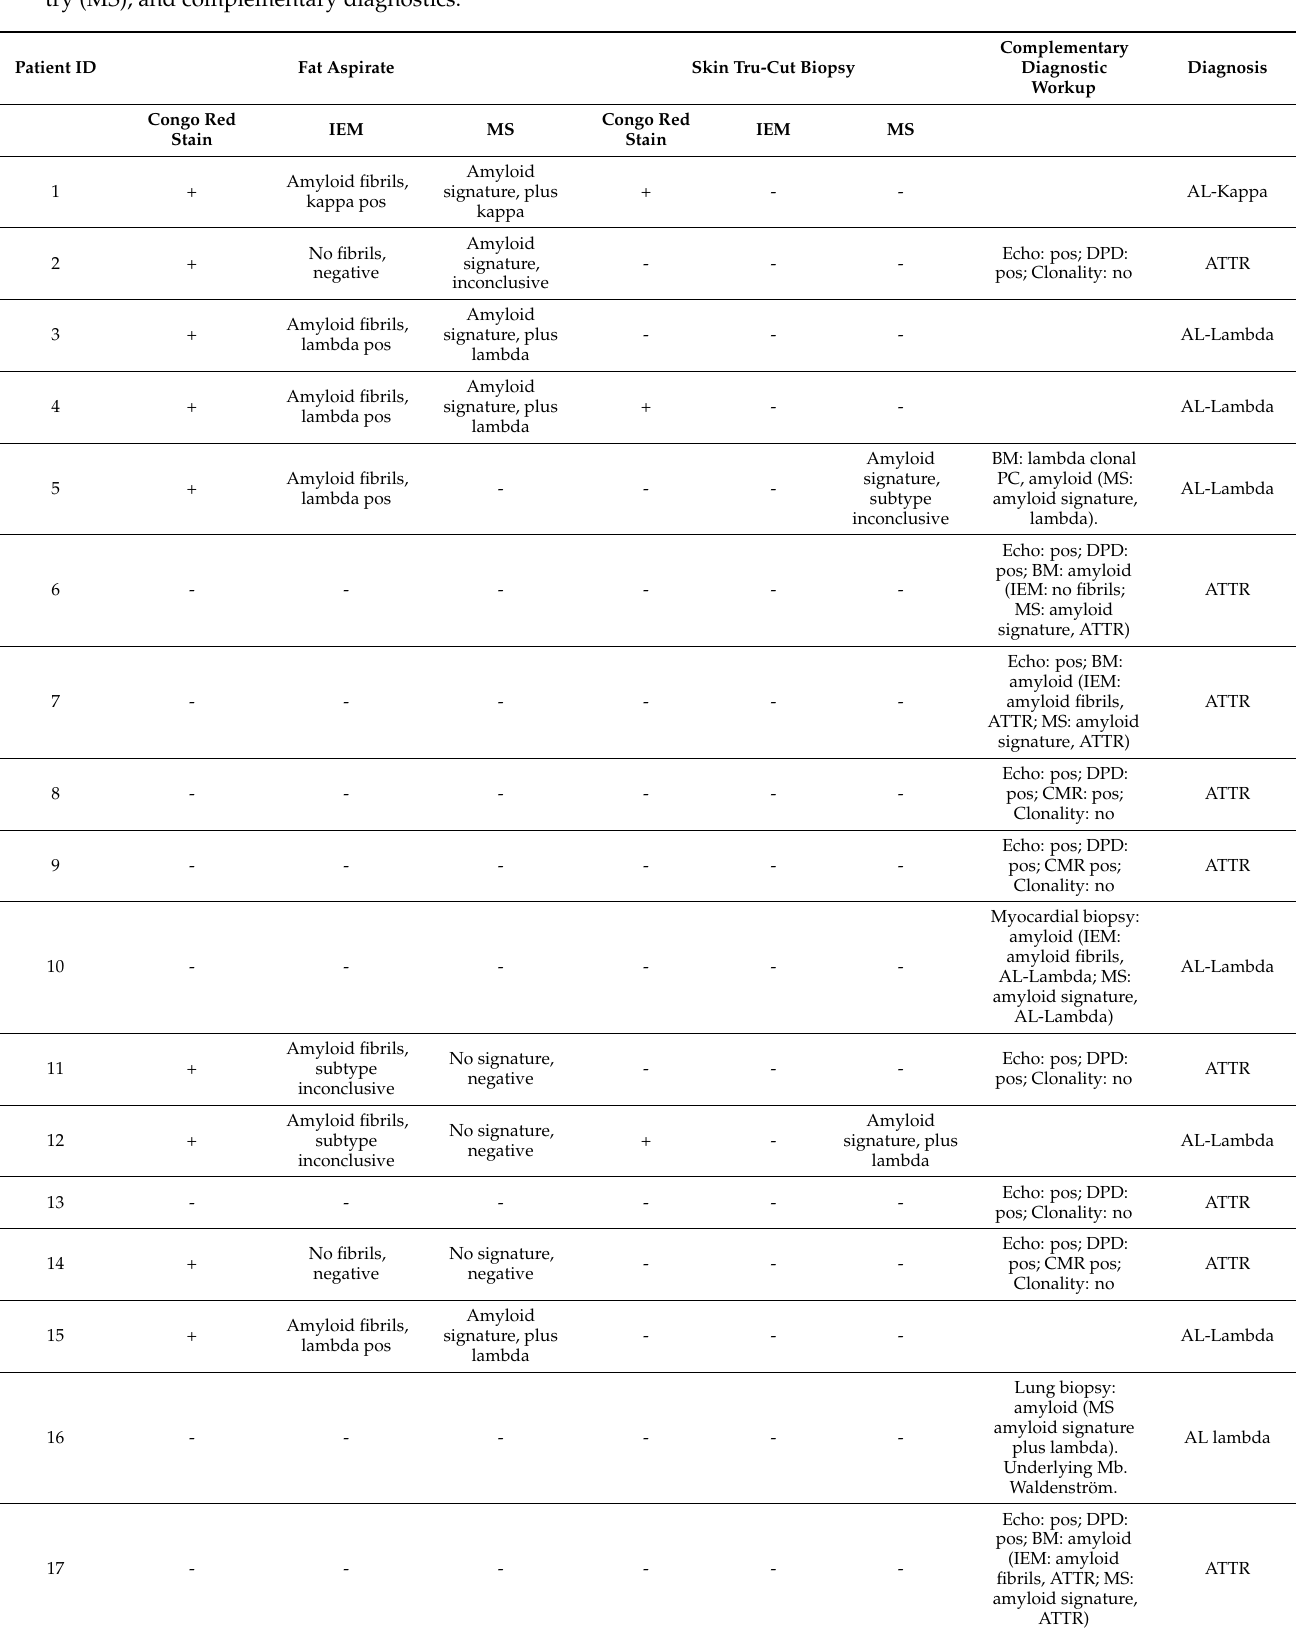
Table 1. Summary of diagnostic findings by Congo Red stain, immunoelectron microscopy analysis (IEM), mass spectrome- try (MS), and complementary